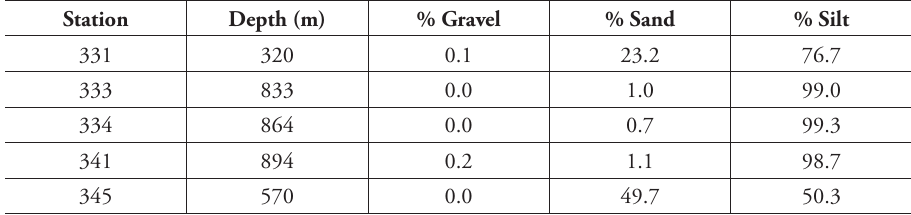
Table 1. Size distribution of analyzed sediment samples according to INVEMAR-ANH (2013).